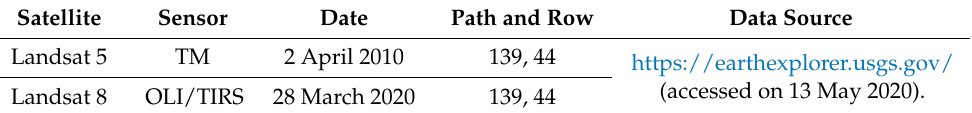
Table 1. Details of the satellite data and acquisition date.